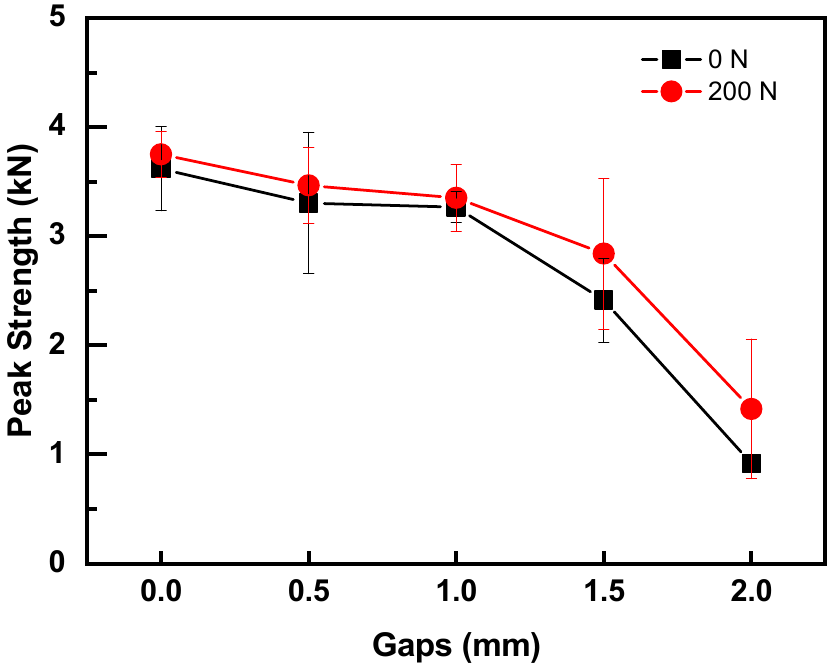
Figure 8. Effect of gap between workpieces on the strengths of normal and preloaded joints (200 N).